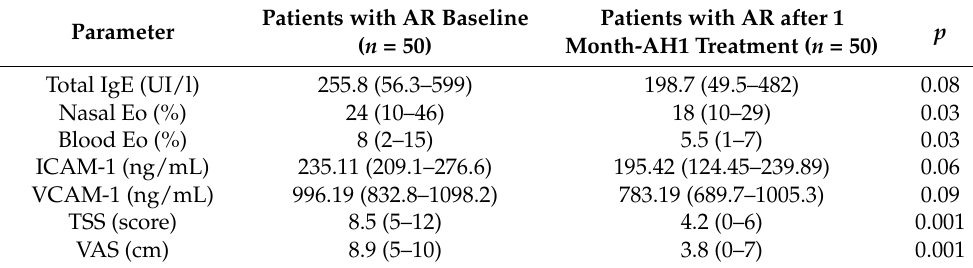
Table 3. Nasal and blood eosinophils, plasmatic values of total IgE and adhesion molecules initially and after 1 month of AH1 treatment in patients with